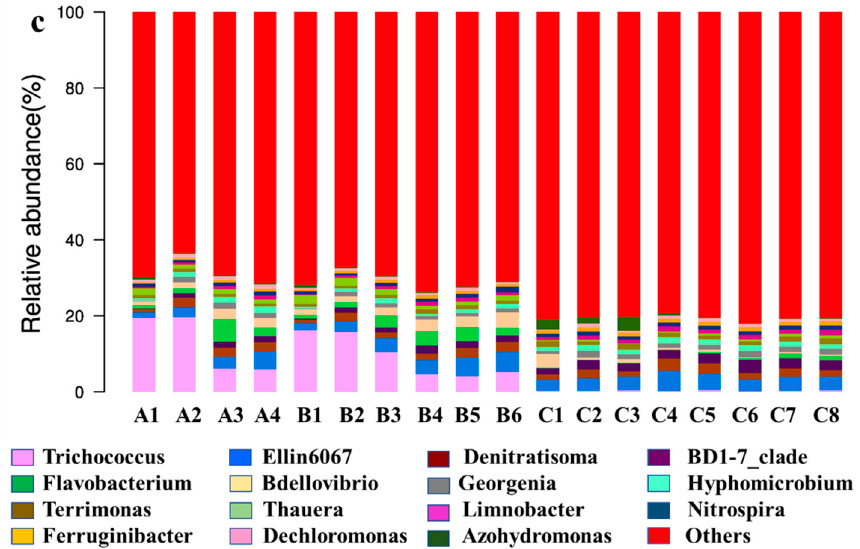
Figure 6. Microbial community structure histogram at the level of phylum, class, and genus for each sample: ( a ) phylum level; ( b ) class level; and ( c ) genus level.